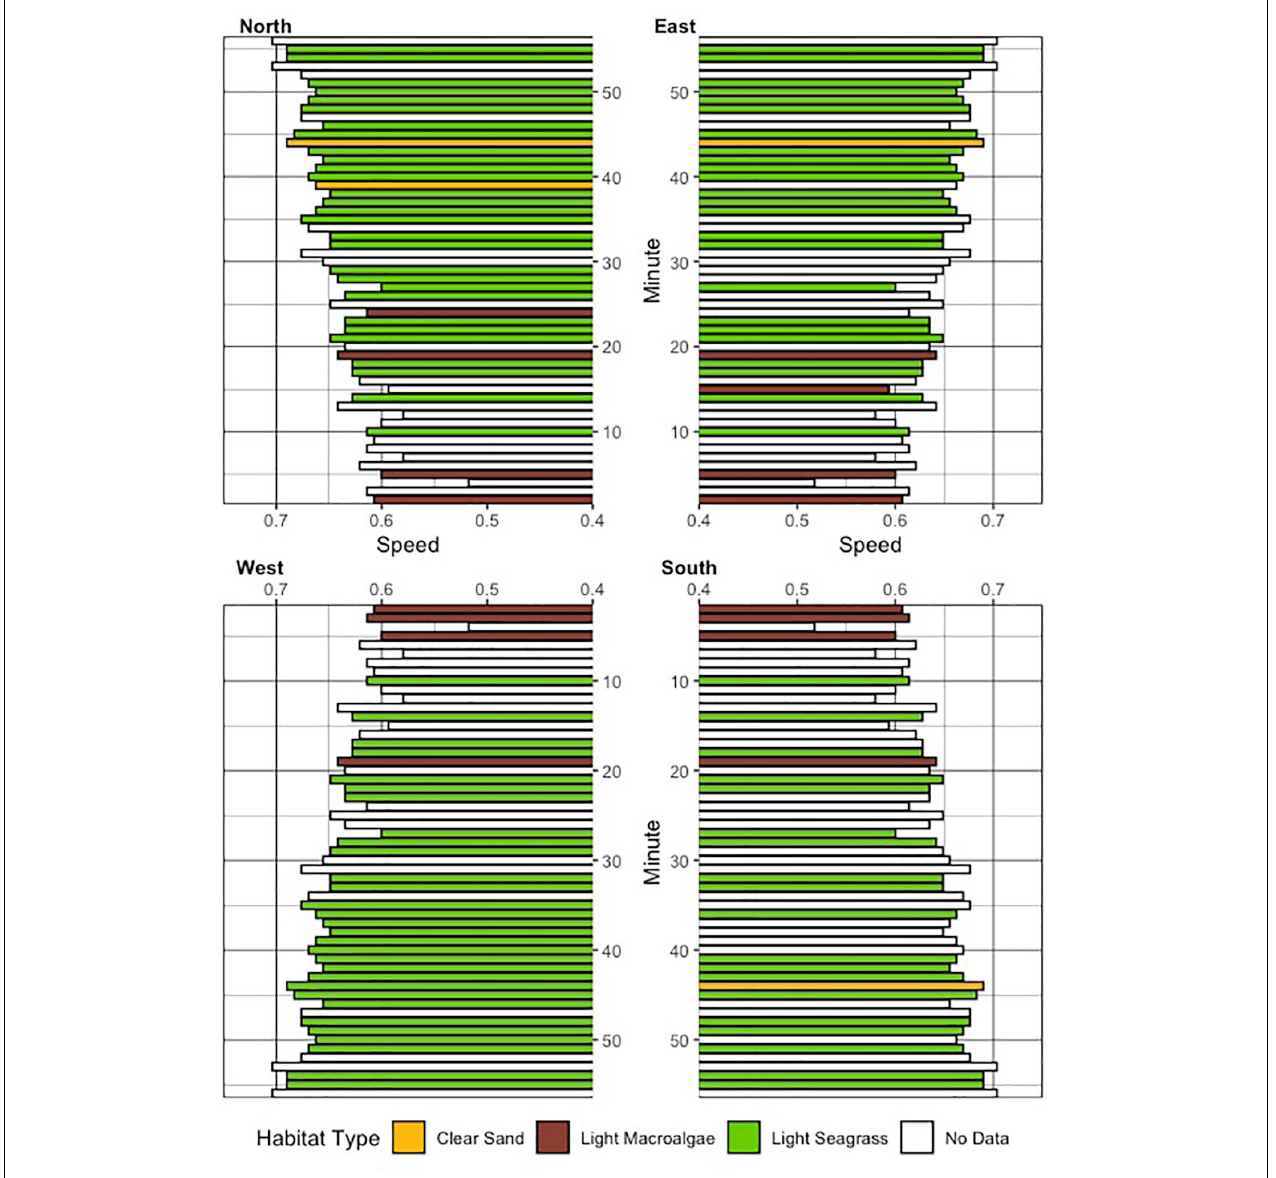
FIGURE 2 | Seafloor habitat classifications (see legend for colors and habitat types) assessed at every minute interval, in each of the 90-degree quadrants of the video. Derived overall estimates of swim speed at each interval are also